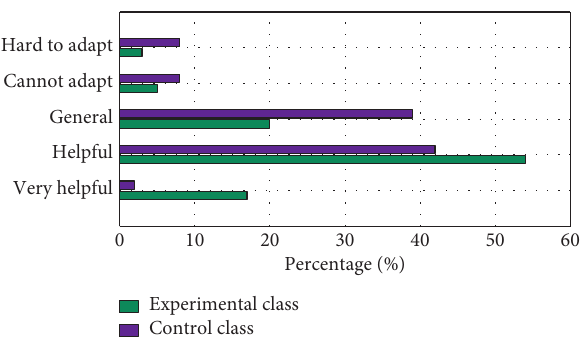
Figure 8: The learner’s degree of adaptability to the teaching